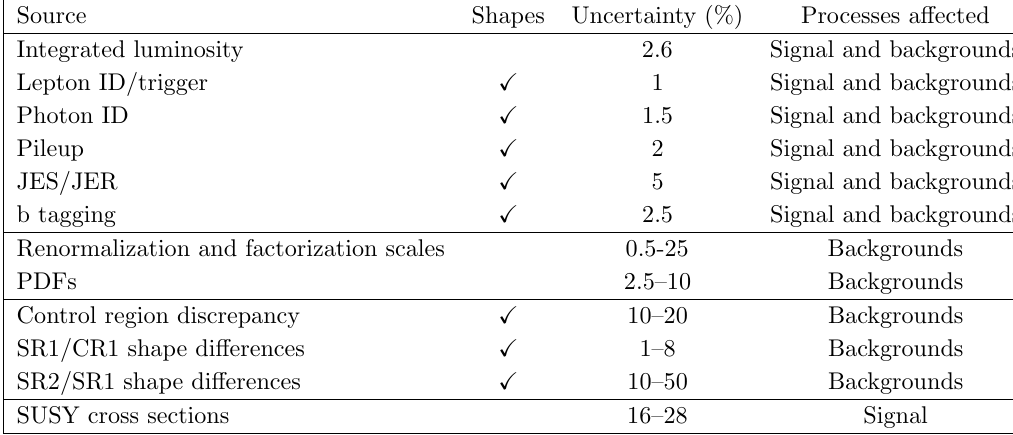
Table 3 . Summary of systematic uncertainties: the dominant uncertainties are extracted from the control region. In the calculation of the upper limits, the normalizations of the tt+jets and tt+ (cid:13) backgrounds are allowed to (cid:13)oat freely in the (cid:12)t. Check marks indicate the uncertainties that a(cid:11)ect the shape of p miss . T